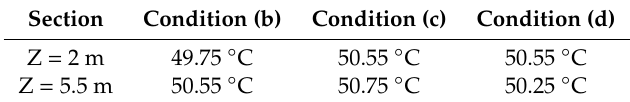
Figure 3. Shutdown order: ( a ) overview, ( b ) left side, ( c ) middle side, and ( d ) right side. Table 3. Section temperature and working condition.